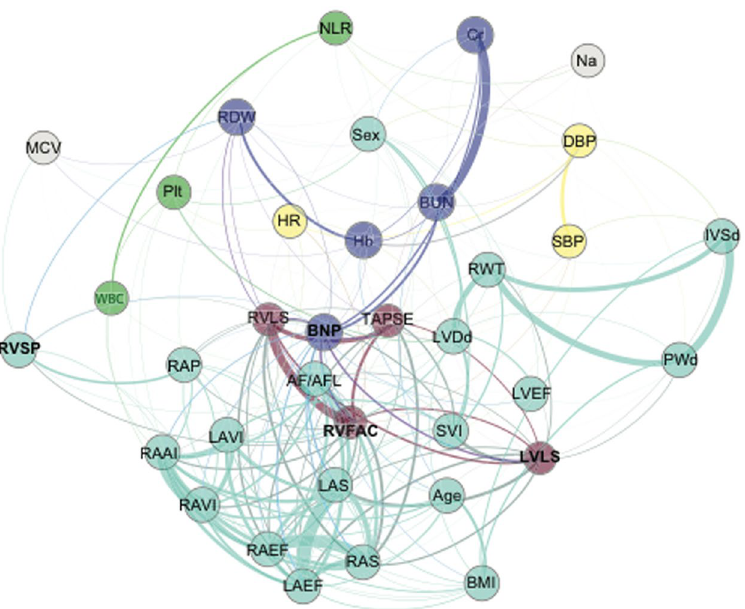
Figure 4. Network analysis of different clinical, laboratory and echocardiographic features. The nodes are colored based on the clusters in Fig. 3. The thickness of the edges reflects the topological overlap between two nodes. Abbreviation; same as Fig.